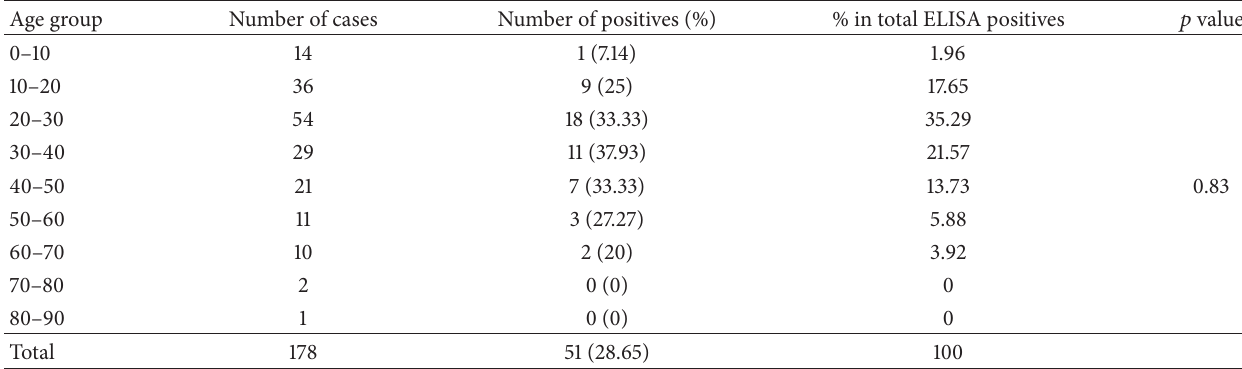
Table 1: Age wise distribution of leptospirosis.